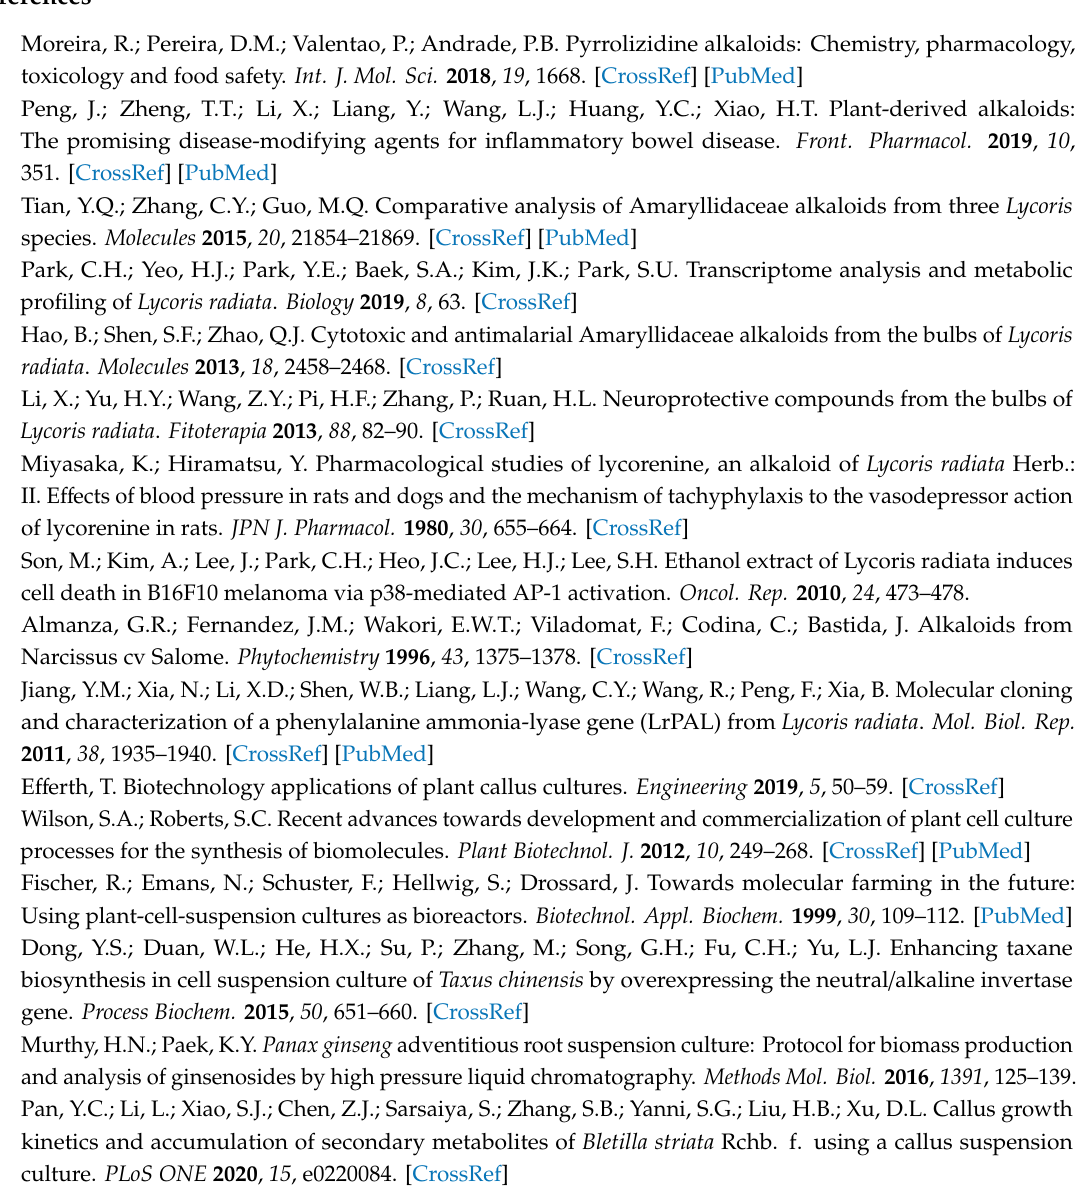
Table S1: Metabolite peak height di ff erences using GS-TOFMS (ratio / g). Table S2. Primers used for qRT-PCR. Table S3: Cq values of β -actin at di ff erent time points after exposure to wounding